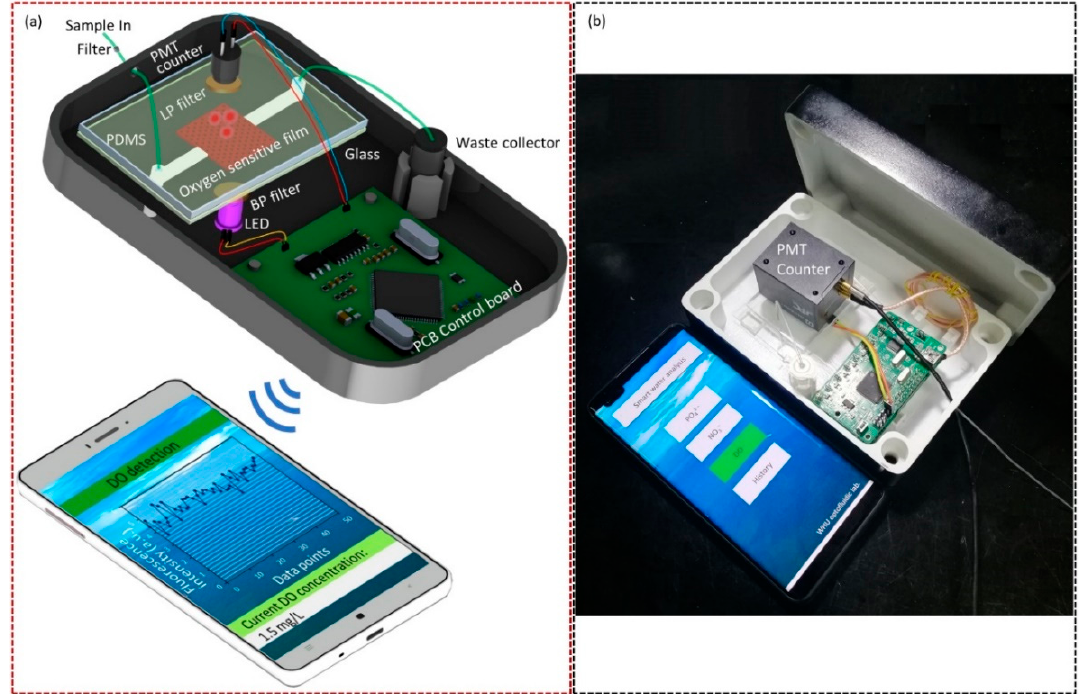
Figure 1. ( a ) Schematic diagram of the fluorescence quenching-based intelligent sensor with patterned microstructures dissolved oxygen (DO) detection. The intelligent sensor is consisted of three functional part: a microfluidic platform, an optical detection module and a smartphone. The mechanism of detection is based on the phosphorescence quenching of the platinum (II) meso-tetrakis(pentafluorophenyl)porphyrin (PtTFPP) sensing film. ( b ) Image depicting the intelligent DO sensor and main interface of the APP on a smartphone.